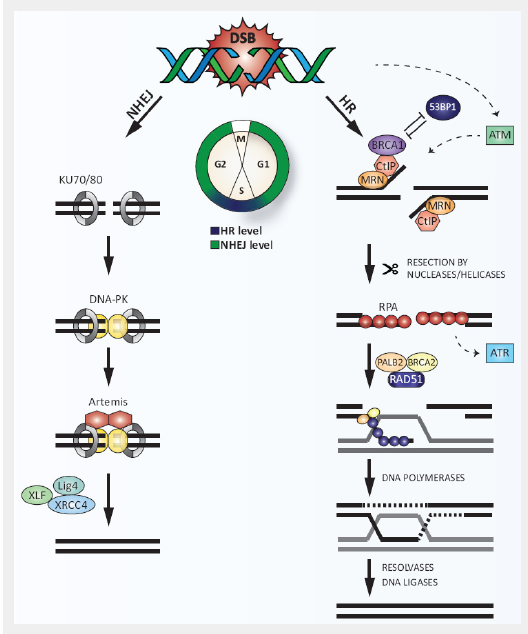
DNA double-strand break (DSB) repair. DSBs are predominantly repaired by two distinct pathways: NHEJ or HR. NHEJ operates throughout the cell cycle, but mainly during the G1 and G2 phases, whereas HR peaks in S phase. Rapid association of the Ku70/80 heterodimer to DSBs promotes NHEJ by recruiting DNA-PKcs. DNA ends are processed by the nucleolytic activity of Artemis, followed by religation catalysed by a complex of XLF, Ligase IV (Lig4) and XRCC4. Alternatively, MRN, which is initially recruited to DSBs in competition with Ku70/80, initiates DSB resection together with CtIP thereby promoting HR. 53BP1 antagonises BRCA1 in DSB resection. Extensive DSB resection by other nucleases and formation of RPA-coated ssDNA stimulates the activation of ATR. Displacement of RPA by RAD51 is mediated by BRCA2 and PALB2, resulting in the formation of RAD51 nucleoprotein filaments. Subsequent strand invasion into the homologous DNA template and capturing of the second DNA end leads to the formation of a double Holliday junction, which is processed by resolvases. Finally, the DNA is sealed by ligases to accomplish error-free repair of the DSB. 53BP = p53 binding protein; ATM = ataxia telangiectasia mutated protein; CtBP = C-terminal binding protein; CtIP = CtBP-interacting protein; DNA = deoxyribonucleic acid; DNA-PK = DNA-dependent protein kinase; DNA-PKcs = DNA-PK catalytic subunit; HR = homologous recombination; MRN = MRE11-RAD50-NBS1 complex; NHEJ = nonhomologous end joining; PALB1/2 = partner and localiser of BRCA1/2; RPA = replication protein A; ssDNA = single-stranded DNA; XLF = XRCC4-like factor; XRCC4 = X-ray repair cross-complementing protein